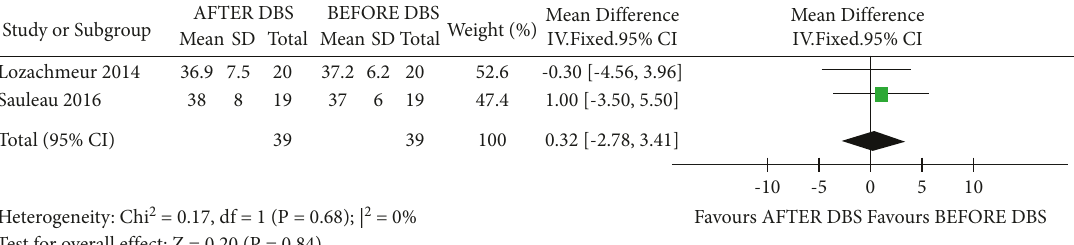
Figure 2: Forest plot for the change in apathy pre-GPi-DBS and